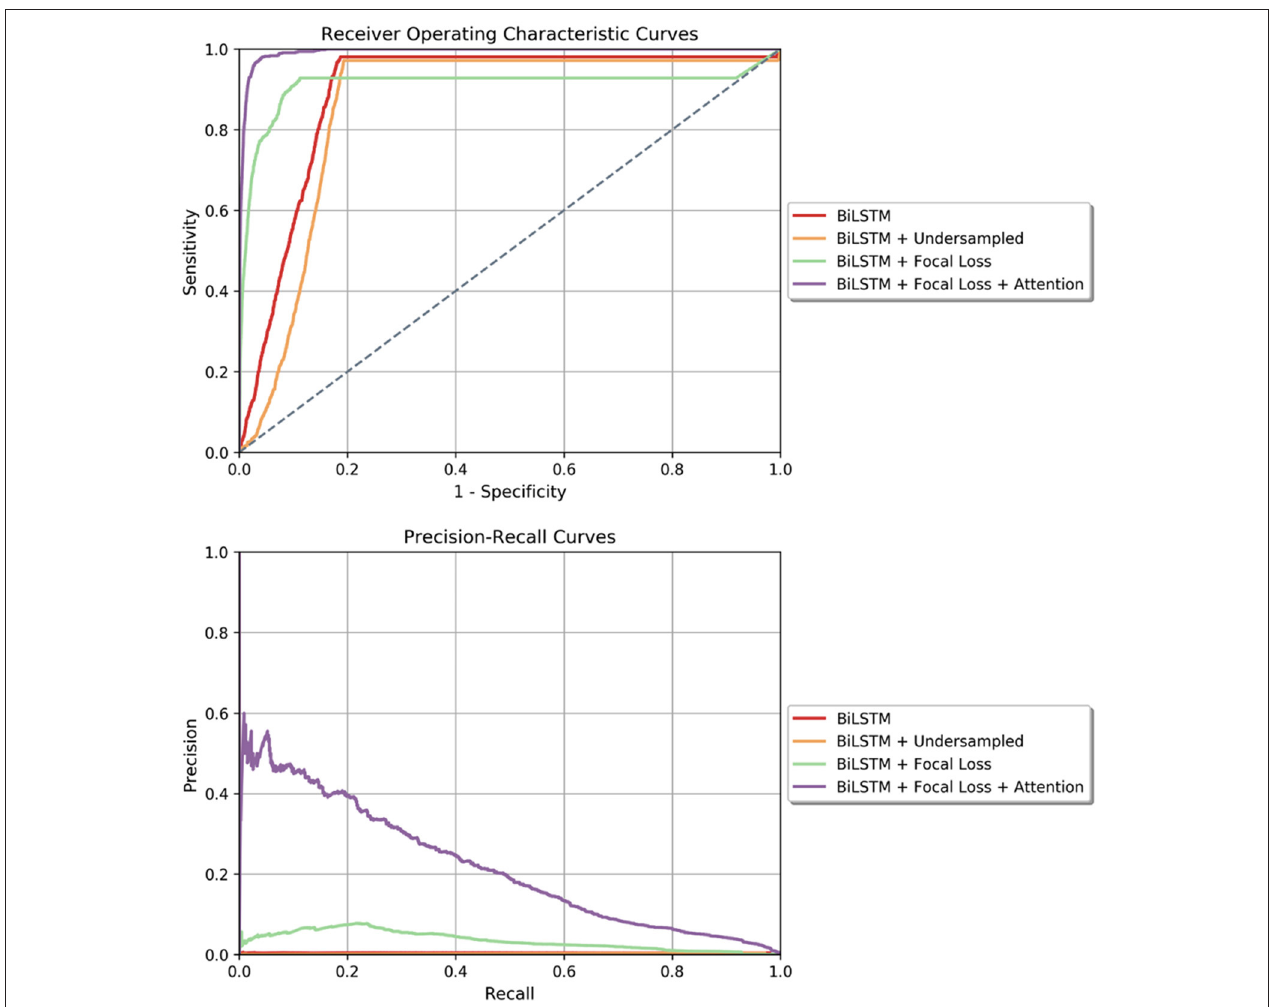
FIGURE 3 | (Top) Receiver Operating Characteristics curves for all four models tested in the window-wise study. (Bottom) Precision-Recall curve for all the models tested in the window-wise study. In both plots, our proposed model which is the Bidirectional LSTM with Focal loss and attention mechanism achieved the highest area under